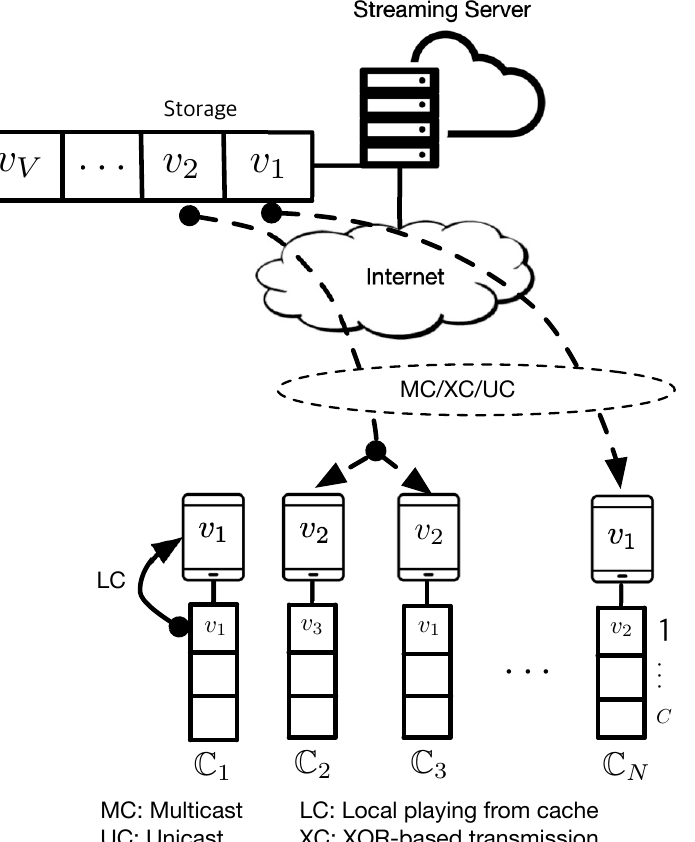
Figure 1. A video streaming system where each client is equipped with a cache size C .